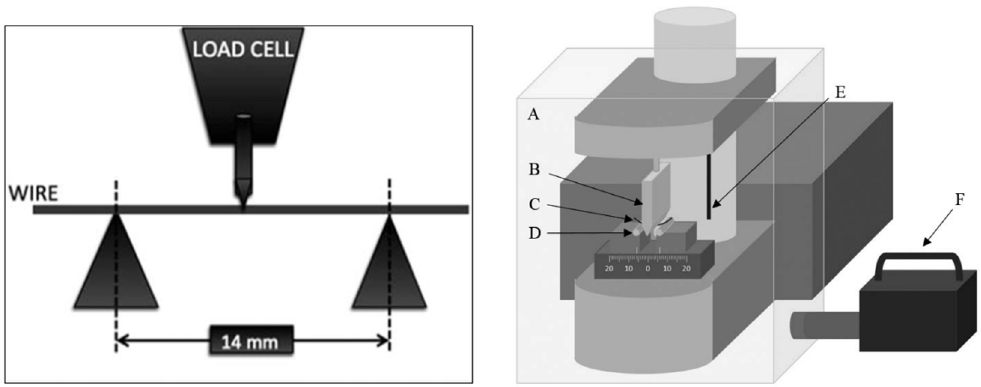
Figure 7. Three-point bending test—scheme; A: thermal screen, B: indenter, C: wire sample, D: supporting points, E: temperature sensor, F: hot-air circulation temperature controller [106,107].